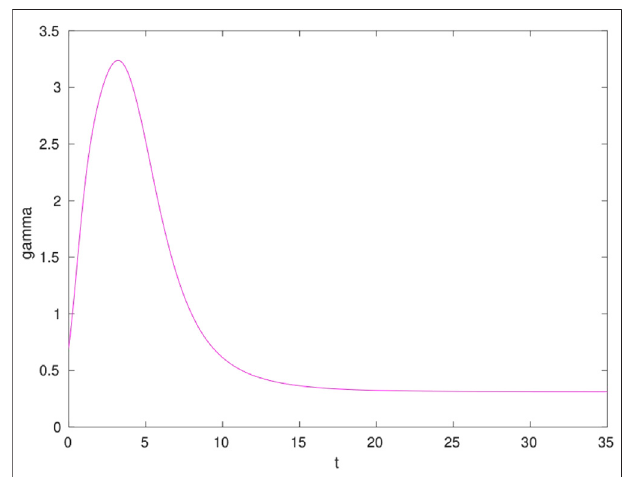
FIGURE 1 | Typical form of time-dependent γ matching the SIR system to the eRG